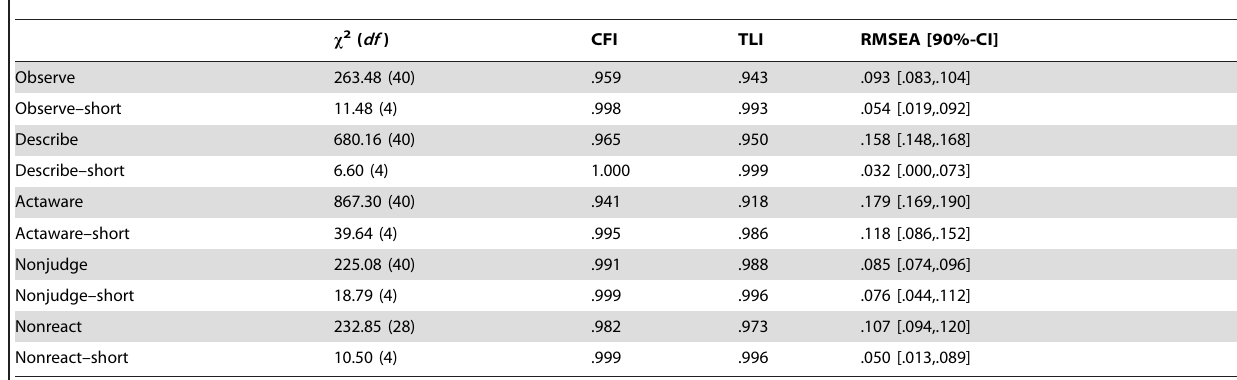
Table 4. Fit of One-Factor Multigroup Models in Individual Facets.